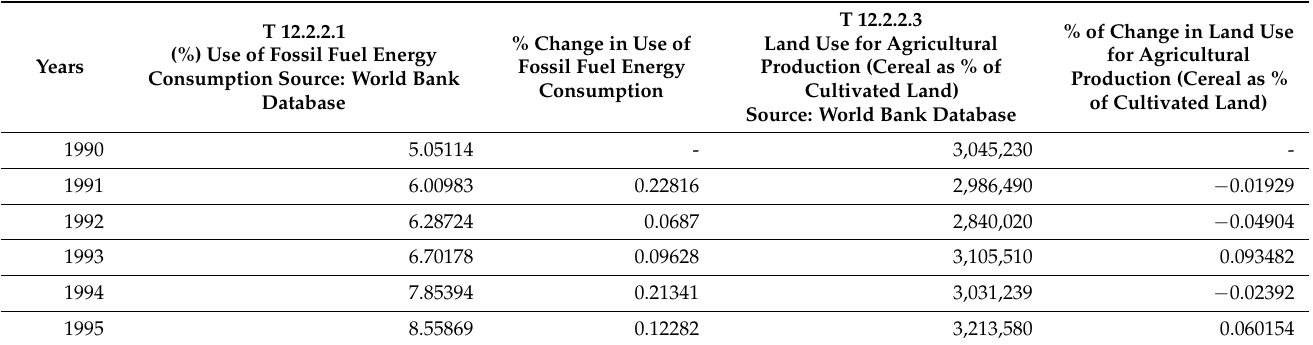
Table A3. Historical dataset for SDG 12 and percent change